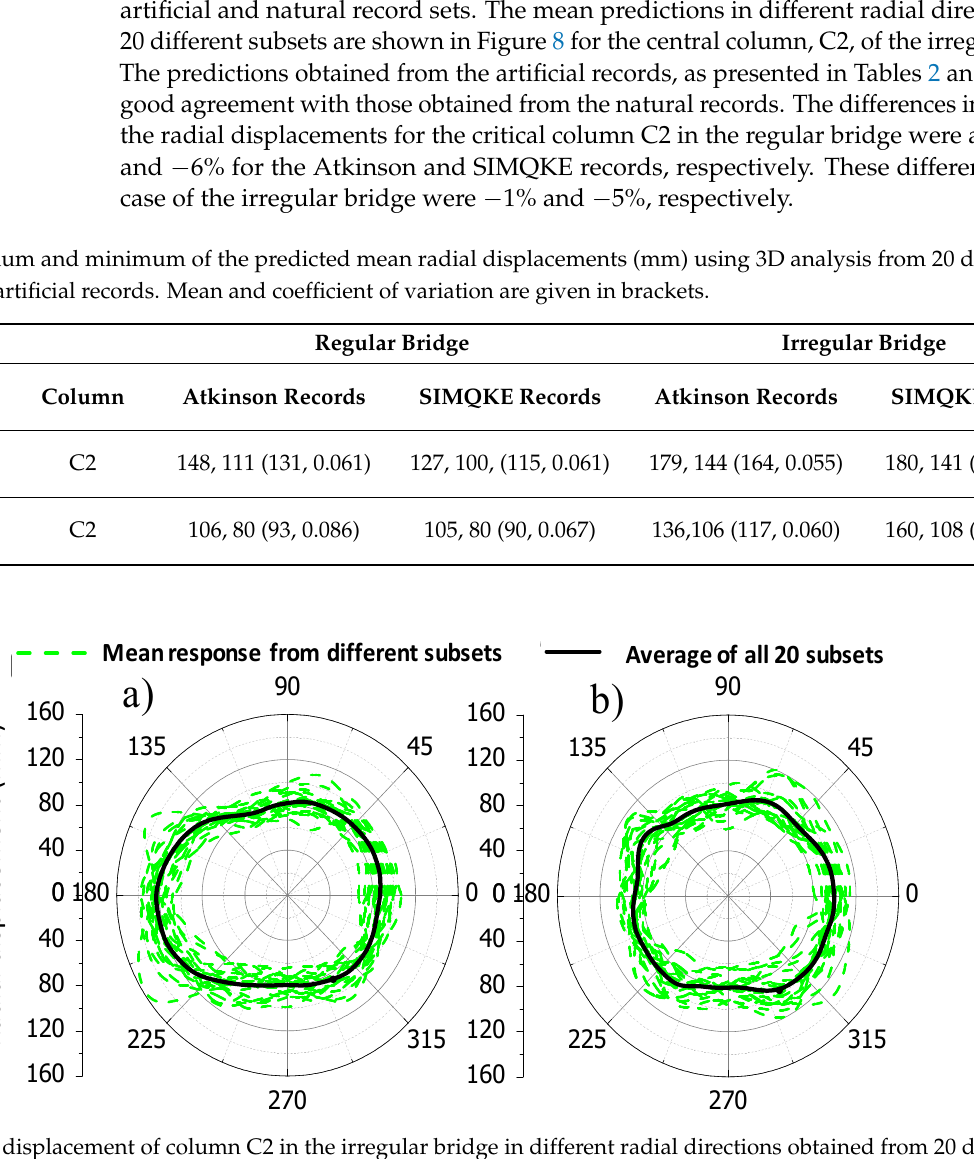
Figure 8. Mean displacement of column C2 in the irregular bridge in different radial directions obtained from 20 different sets of pairs of horizontal components for: ( a ) SIMQKE records and ( b ) Atkinson records.